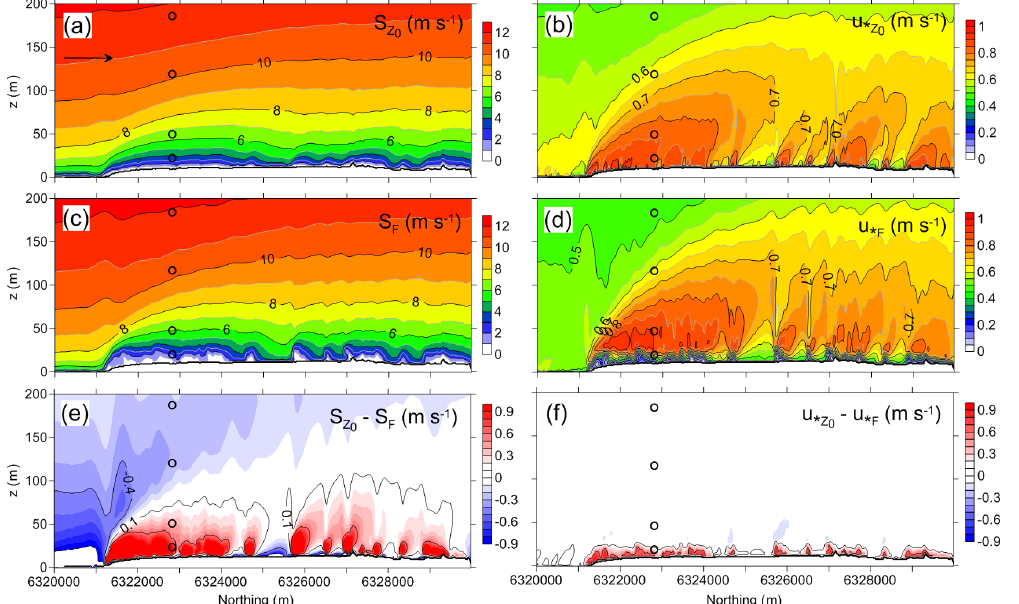
Figure 5. Two-dimensional fields of (a, c) wind speed ( S ) and (b, d) local friction velocity ( u ∗ ) along the south-north transect (see location in Fig. 2b) modelled by EllipSys3D using the effective roughness (subscript z 0 ) and the canopy drag (subscript F ) approaches. The differences in values of S and u ∗ derived using two different approaches are also shown in (e) and (f) , respectively. Arrow in (a) shows the flow direction. Thick black lines in panels indicate the surface. Open circles in panels indicate observation